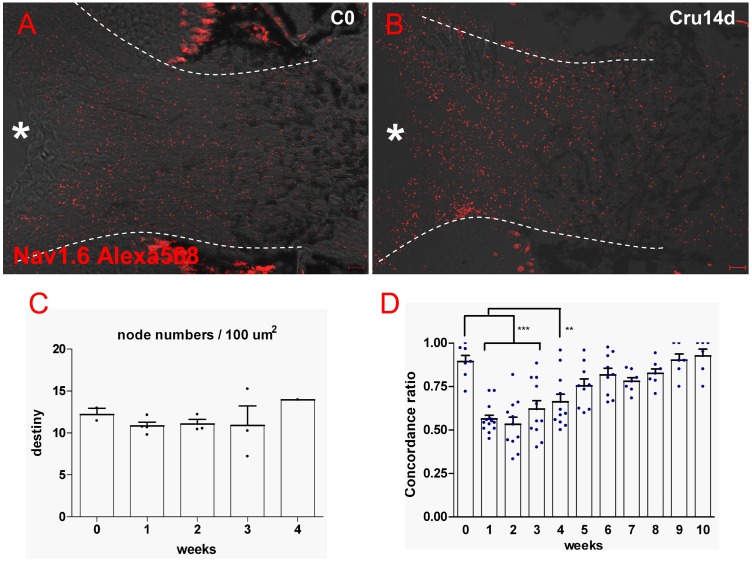
(A, B) The density of Ranvier node in optic disc is not influenced by optic nerve injury.(C) Quantitative result shows Ranvier node density in disc is not decreased following ONI. (D) OMR result shows gradual recovery of visual function. After 5 weeks of binocular optic nerve crush, concordant ratio returns to normal level (p>0.05) and visual function is completely recovered at 9 wpi (100% recovery). ** indicates p<0.01, *** is p<0.001. Scale bar: 10 µm (B).